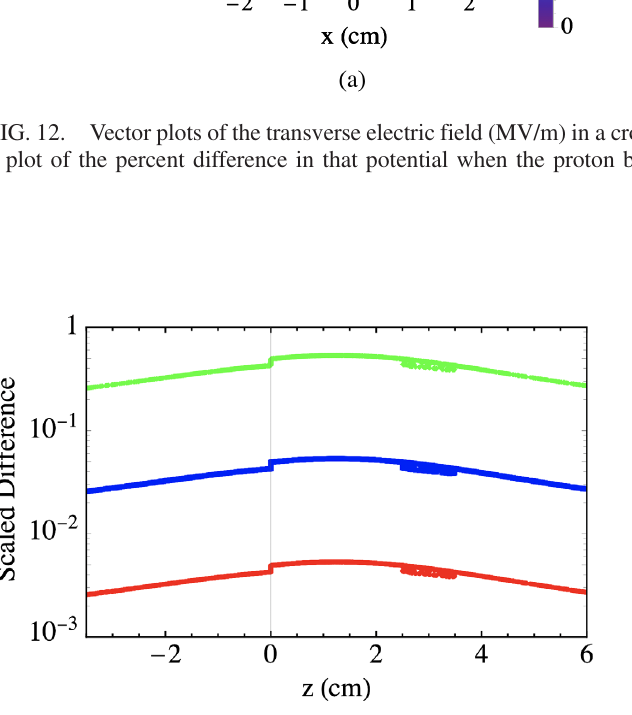
FIG. 13. Modifications in the boundary conditions (scaled by the maximum boundary potential) due to the presence of the proton beam (red line). Additional results shown for 10 (blue line) and 100 (green line) times the number of particles.